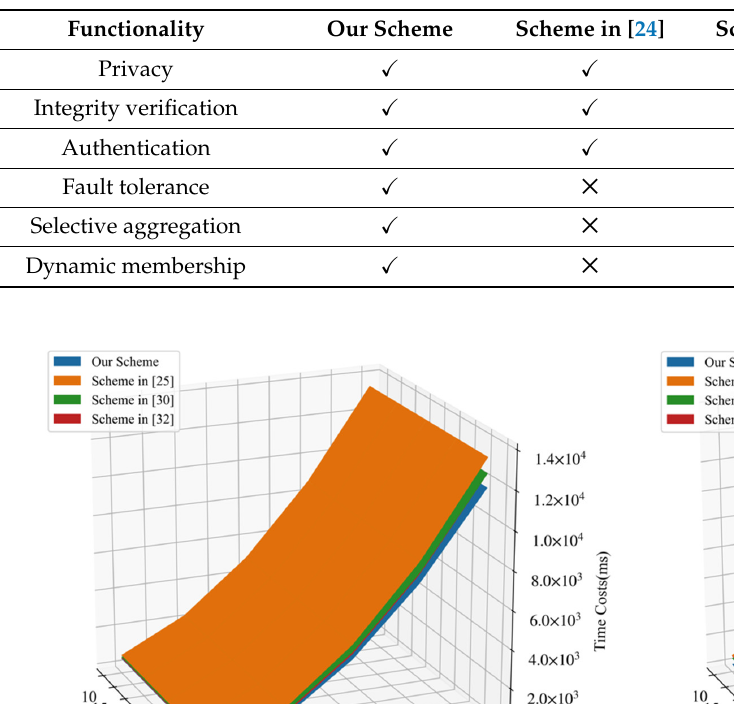
Table 4. Comparison of overall computation costs.